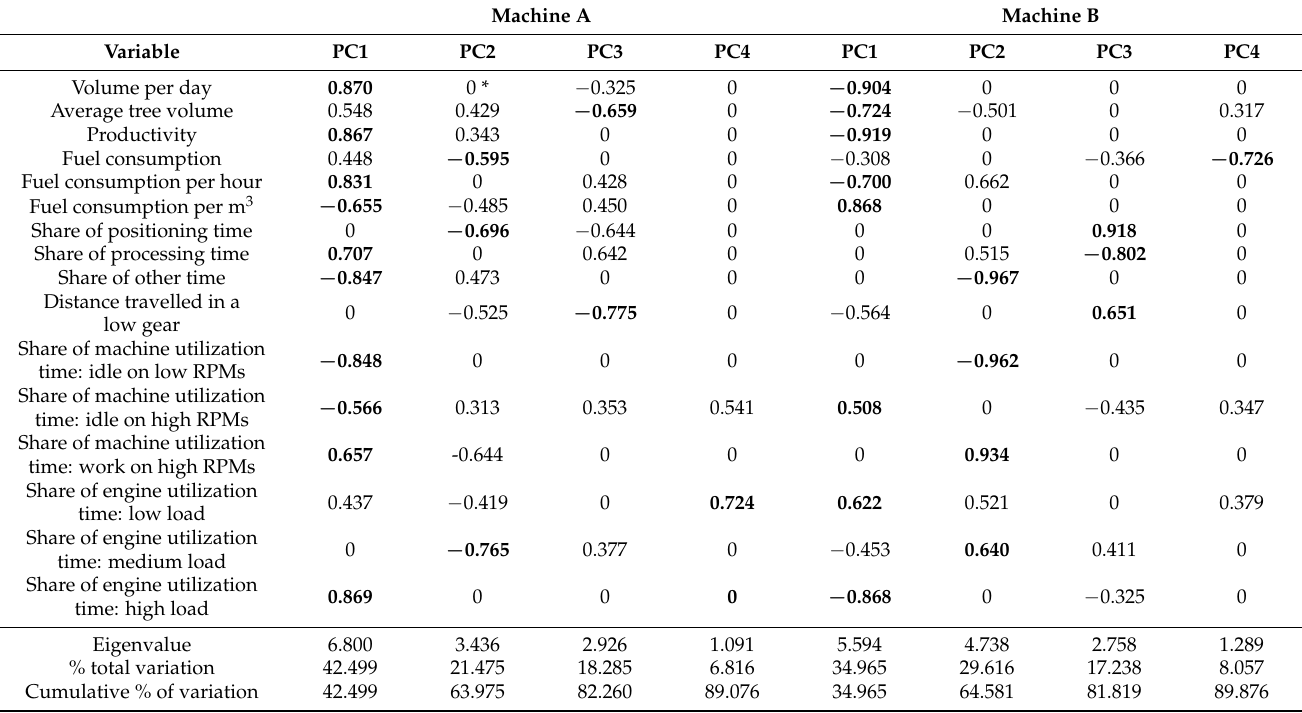
Table 2. Variables contributions to 4 main principal components (PCs) for each machine. The highest weight of a variable is bolded. Machine A Machine